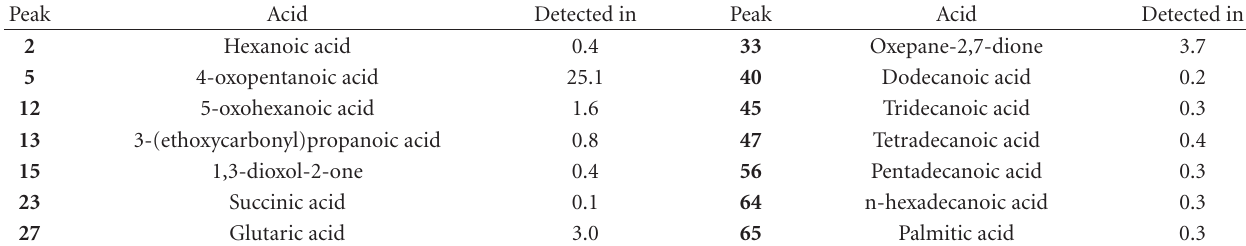
Table 6: Acids detected in the products from ASF ODVR .